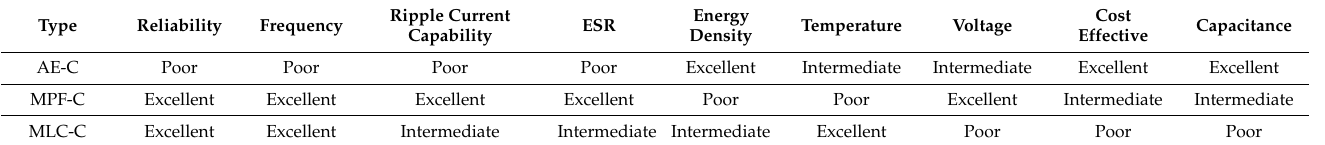
Table 1. Relative performance comparisons of the three main types of capacitors for DC-BUS applications.